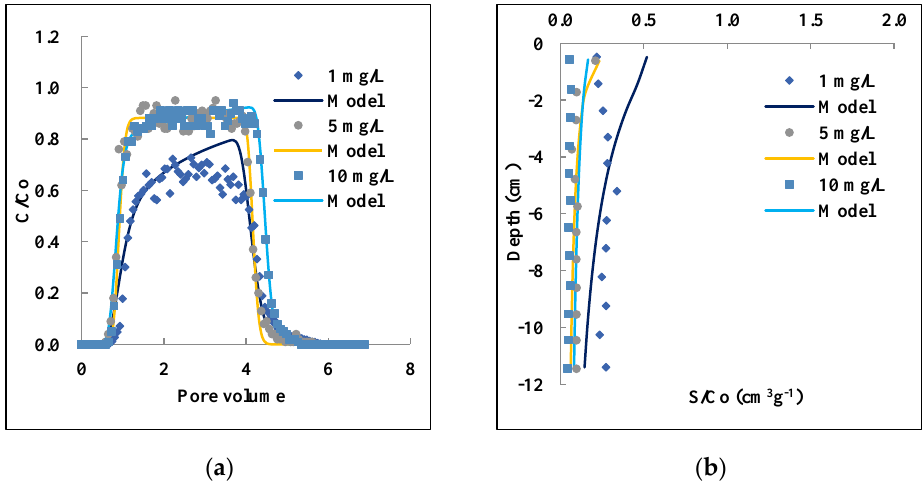
Figure 1. Effect of input concentration of 1, 5, and 10 mg L −1 on the transport and retention of PAM@MNP in saturated QS column: Observed and modeled BTCs ( a ) and RPs ( b ). IS: 1 mM, grain size: 607 μm, Darcy velocity: 0.28– 0.29 cm min −1 .